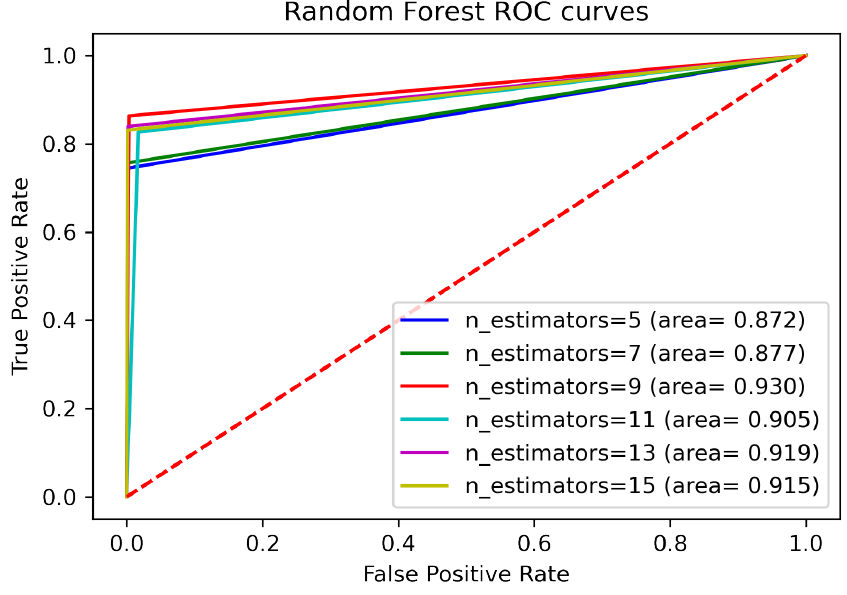
Figure 12. ROC curve comparing the performances with varying values of numbers of